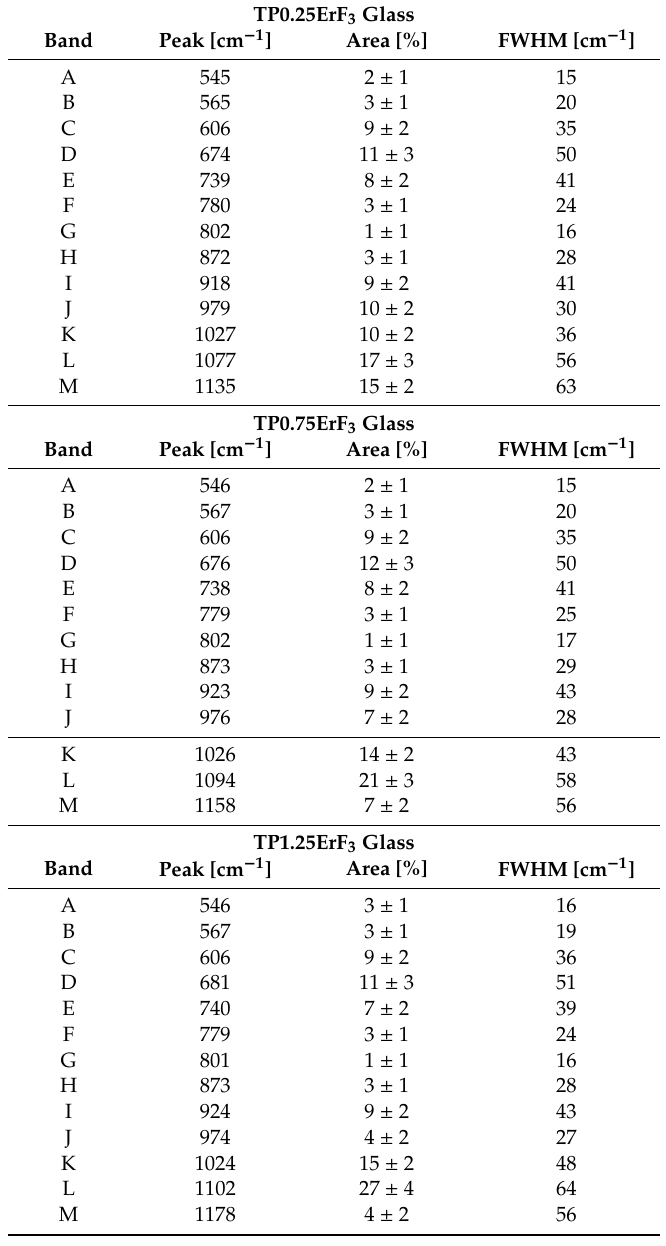
Table 2. The parameters of bands obtained by deconvolution of the FTIR spectra of TP0.25ErF 3 , TP0.75ErF 3 , and TP1.25ErF 3 glasses.